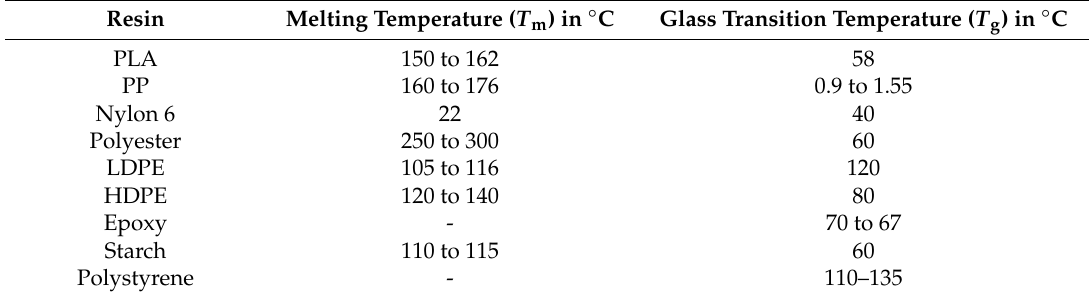
Table 5. The melting temperature ( T m ) and glass transition temperature ( T g ) of some commonly used resins